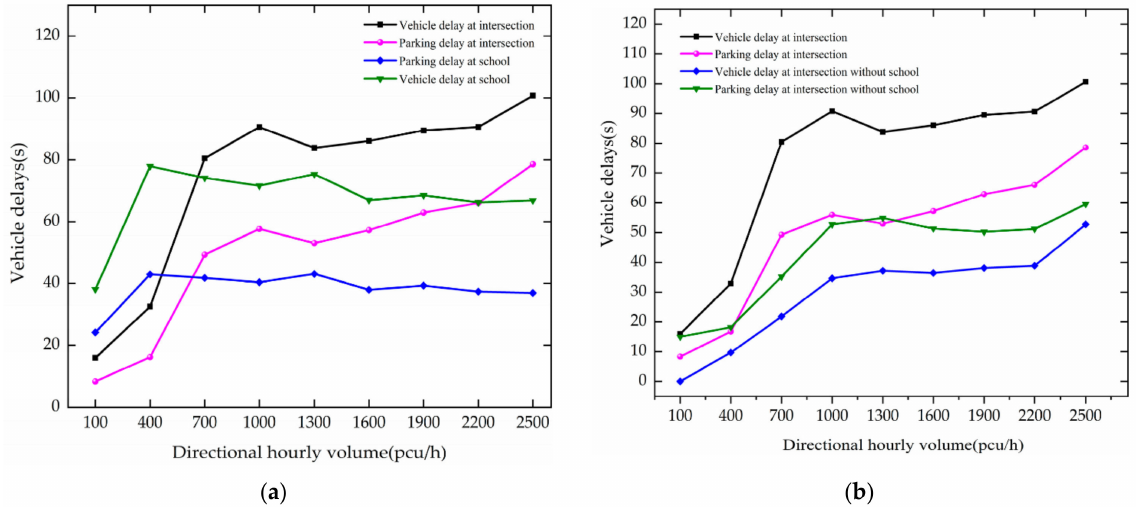
Figure 5. Variation trend of vehicle delay with DHV. ( a ) vehicle delays when there is a school. ( b ) vehicle delays without a school.